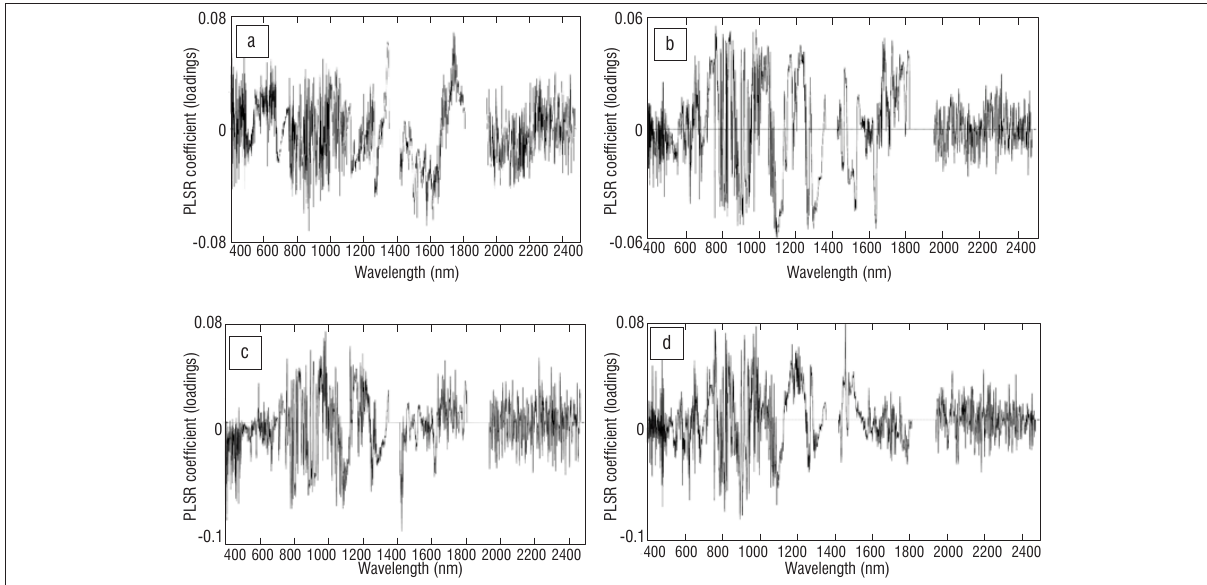
Figure 3: Partial least square regression (PLSR) loadings for (a) beginning of, (b) mid- and (c) end of summer and (d) pooled data. Table 2: Selected bands (nm) using interval partial least square regression models with 40 intervals for the three sampling periods in summer and the pooled data Visible Red edge Near infrared Short-wave infrared Beginning of summer